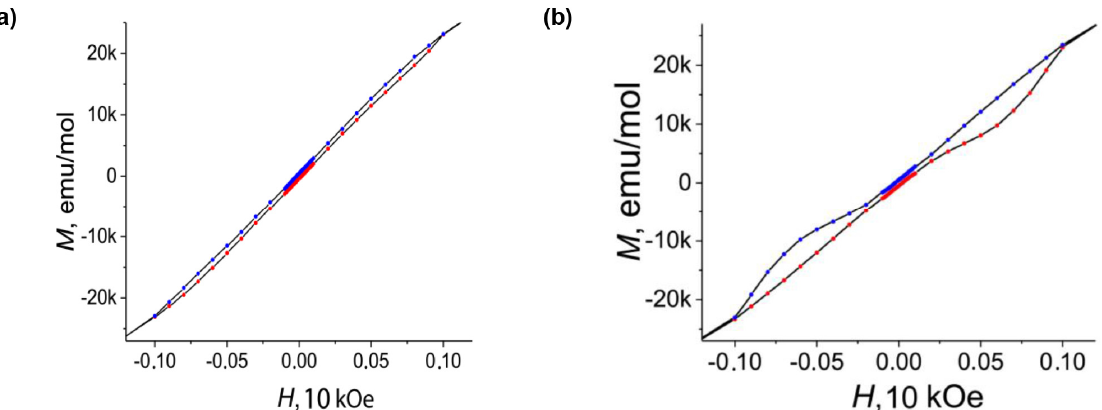
Figure 4. Hysteresis loops for powdered (Pc)Tb[(15C5) 4 Pc]Tb(Pc) 1 ( a ) and polycrystalline sample of (Pc)Tb[(15C5) 4 Pc]Tb(Pc) 6C 6 H 4 Cl 2 2 ( b ) measured at 2 K in 20 Oe/s magnetic field.